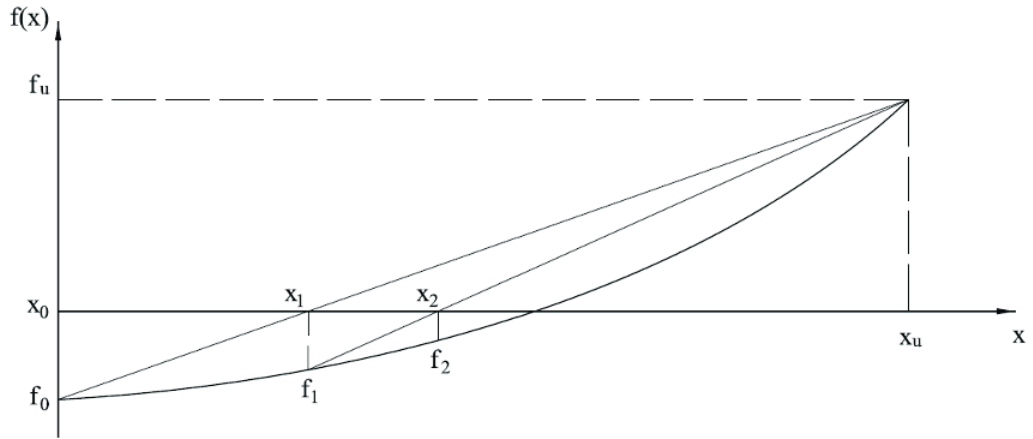
Secant method – adapted from ARAÚJO